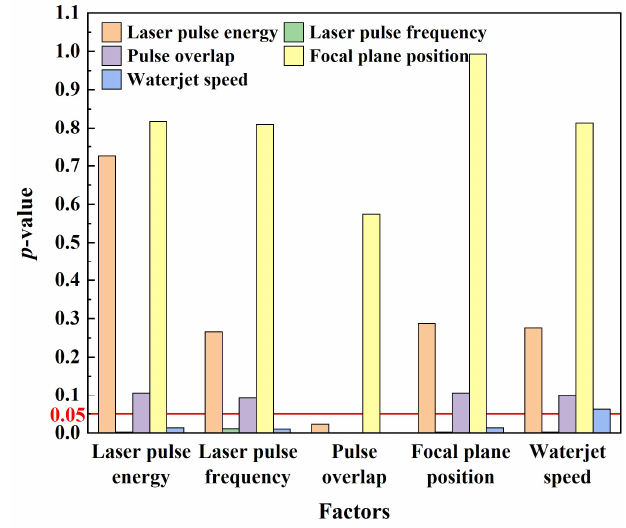
Figure 10. Variance analysis diagram of orthogonal experiment. Table 7. Range analysis of the orthogonal experiment.